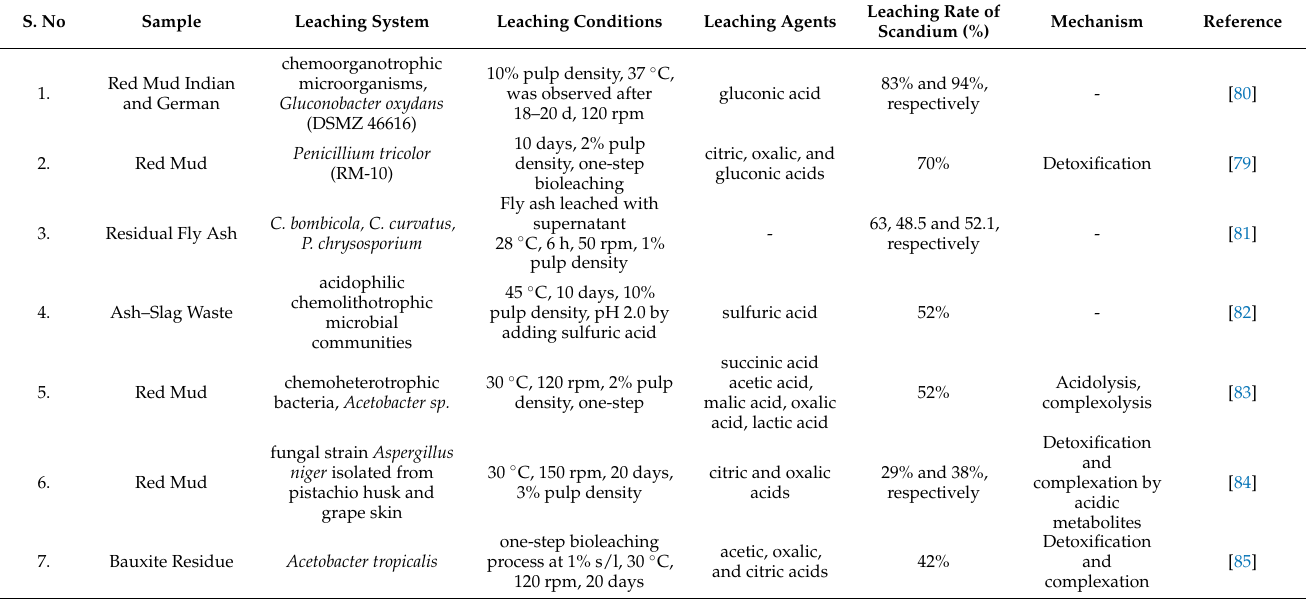
Table 4. A brief summary of different systems of scandium leaching from secondary